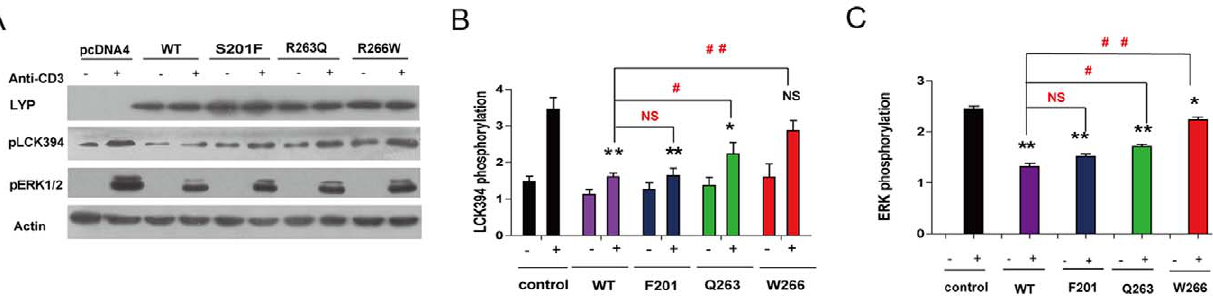
Figure 4. Effect of Lyp and 3 variants on T cell signaling. (A) Jurkat T cells were transfected with the His/Myc tagged full-length Lyp plasmids or mutated variants, and stimulated with medium or anti-CD3 (OKT3) antibody for 5 min. The level of full-length Lyp protein was detected by anti- Myc antibody. The phosphorylation of Lck394 and phosphorylation of ERK1/2 were monitored by immunoblotting with specific antibodies. Actin was detected as loading control. (B–C) Statistical analysis of Lck394 phosphorylation and ERK1/2 phosphorylation in Jurkat T cells overexpressed with Lyp wild type and variants. ** represents P , 0.01 compared to the signals in control T cells stimulated with anti-CD3. ## represents P , 0.01 compared to the stimulated signals in T cells overexpressed with wild-type Lyp.